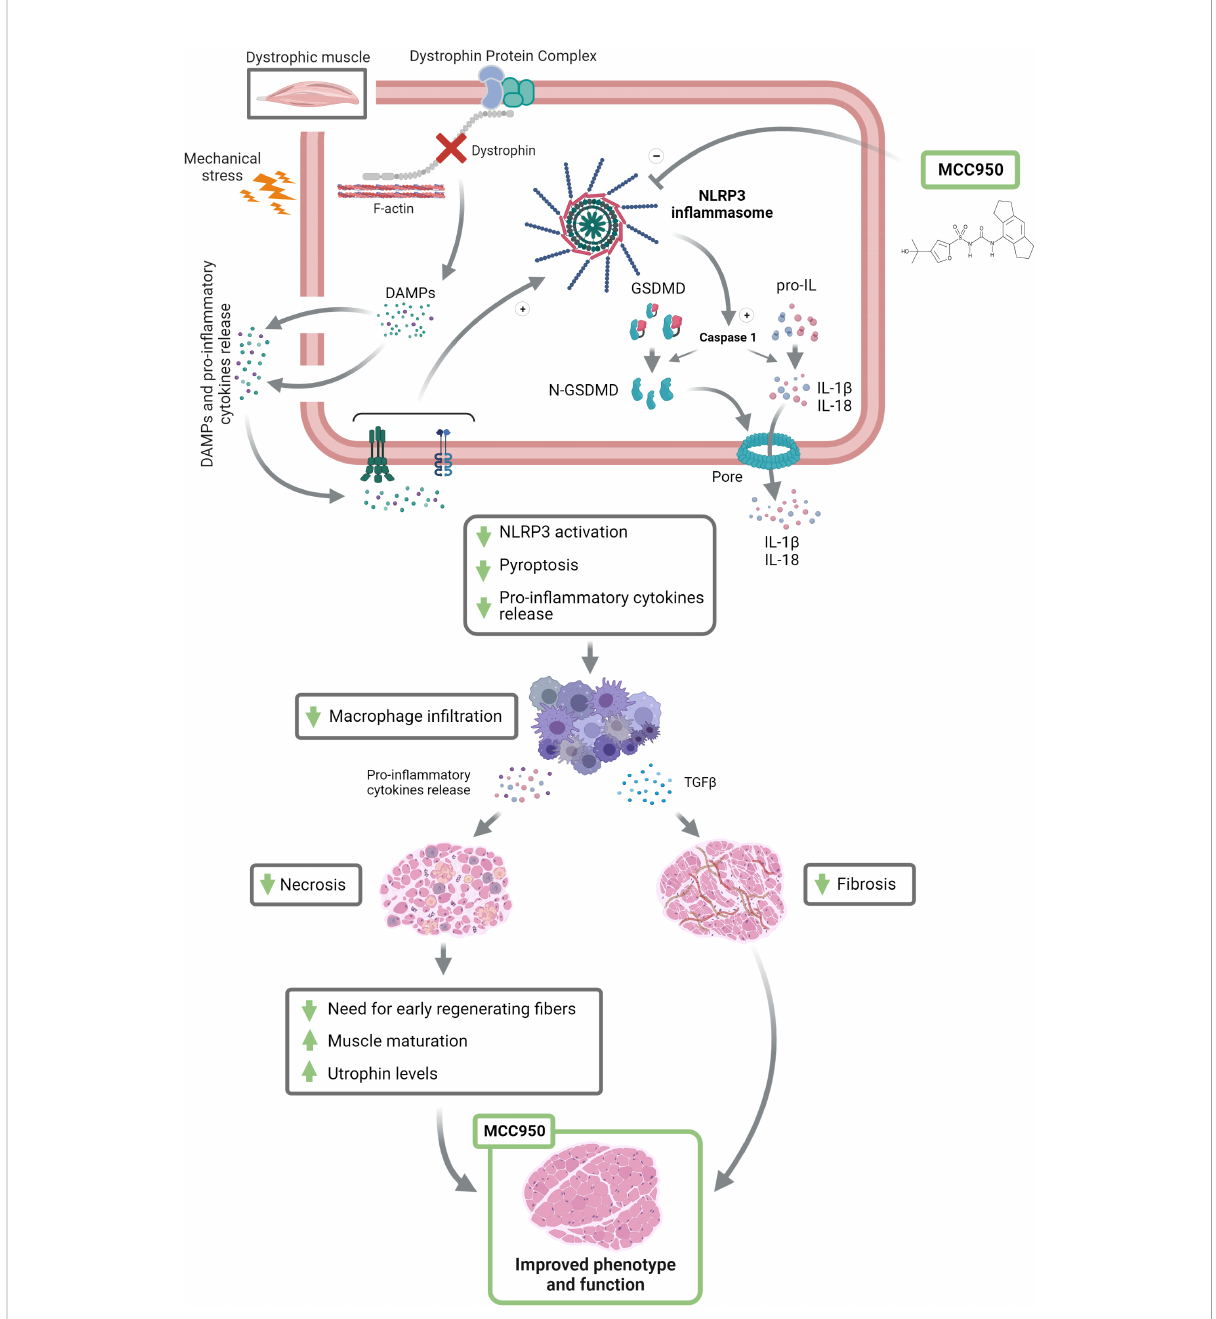
FIGURE 8 Inhibiting the in fl ammasome helps rescue the dystrophic phenotype . DMD gene mutations cause the absence of the dystrophin protein, which weakens the fi bre membrane making it more sensitive to mechanical stress. This leads to microtears and the release of damage-associated molecular patterns (DAMPs) and pro-in fl ammatory cytokines. The latter will activate NLRP3 in fl ammasome and consequently caspase-1, which in turn cleaves and activates N-GSDMD, IL-1 b and IL-18, leading to pyroptotic channel formation and the release of mature pro-in fl ammatory cytokines. By blocking NLRP3, MCC950 could markedly attenuate this process. This bene fi cial action will decrease macrophage (M1 and M2) in fi ltration and shift the macrophage polarization towards an anti-in fl ammatory phenotype (M2), leading to anti-necrotic and anti- fi brotic properties. Finally, MCC950 will allow for a better myo fi bre maturation and increase utrophin expression, therefore leading to an improved muscle function and phenotype. +, stimulation; -, inhibition; GSDMD, gasdermin D. This fi gure was created with